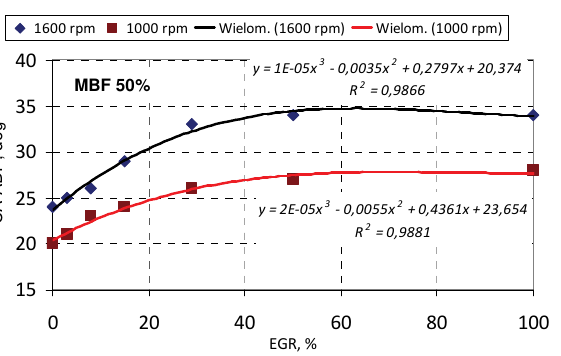
Fig. 13. Impact of EGR opening at MBF 50% value (190 Nm load)